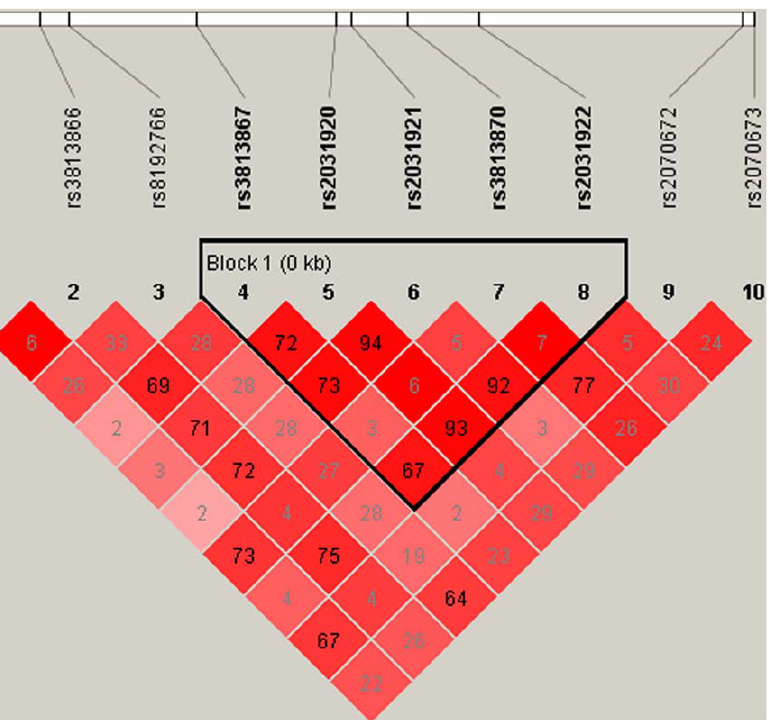
Figure 1. LD plot for CYP2E1 . The LD plots were generated by Haploview 4.2. r 2 between marker pairs is indicated by the shaded matrices. This figure shows that strong LD was observed between rs3813867, rs2031920, rs2031921, rs3813870 and rs2031922.